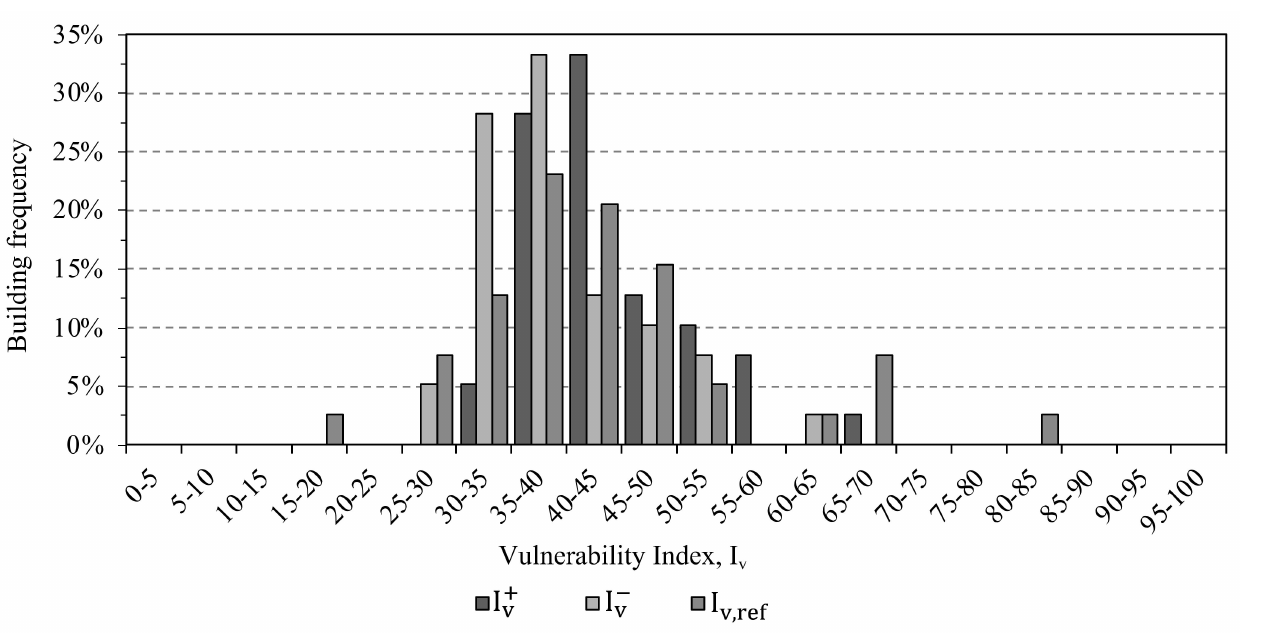
, and I − ) are more concentrated v v